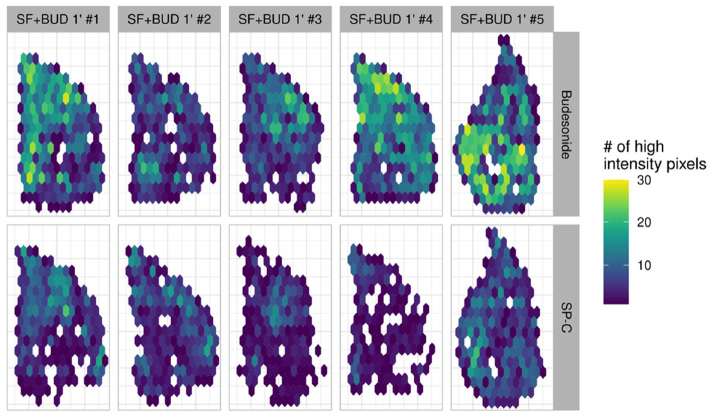
Figure 3. Two-dimensional density maps of the budesonide (top row) and SP-C (bottom row) from premature lambs that were ventilated for just. 1 min after either receiving intratracheal budesonide (0.25 mg/kg) combined with surfactant (200 mg/kg, SF+BUD 1′). SP-C and budesonide were analyzed in consecutive lung tissue sections using different sample preparation protocols.